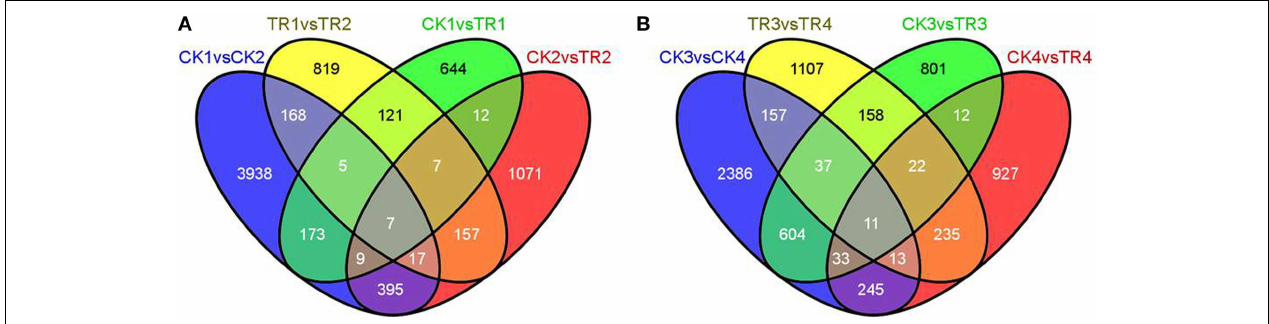
FIGURE 5 | Venn diagrams with numbers of shared and unique differentially expressed genes. (A) DE genes between CK1 vs. TR1, CK2 vs. TR2, CK1 vs. CK2, and TR1 vs. TR2. (B) DE genes between CK3 vs. TR3, CK4 vs. TR4, CK3 vs. CK4, and TR3 vs. TR4.